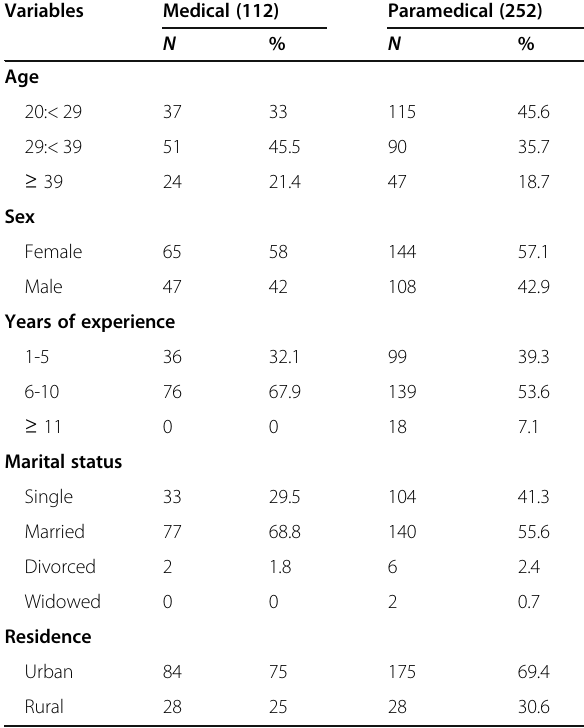
Table 1 Frequency distribution of demographic characteristics of the studied staff (medical and paramedical) ( n = 364)